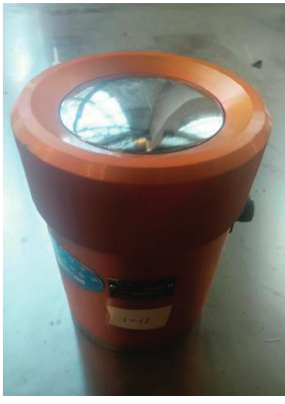
Figure 11: Loading sensing cell.